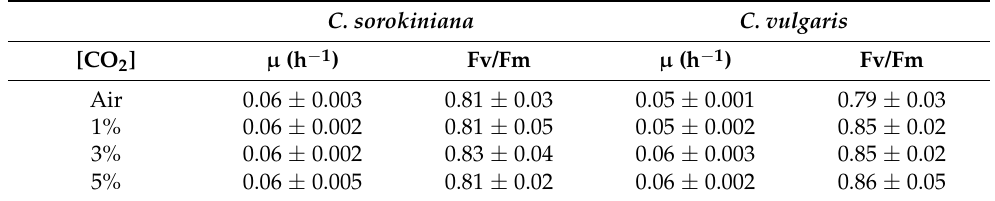
Table 1. Specific growth rate µ (h − 1 ) and the maximum quantum yield of PSII (Fv/Fm) calculated from Chlorella cultures grown in increasing CO 2 concentrations (0% to 5% CO 2